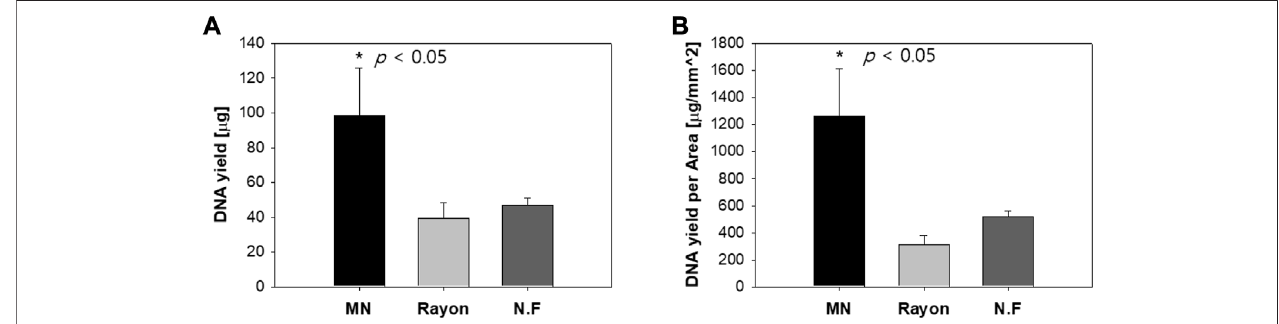
using 2 MN swabs of S-N4-I2-S20 and Z-N4-I2-S20 having the same number and spacing of microneedles. As shown in